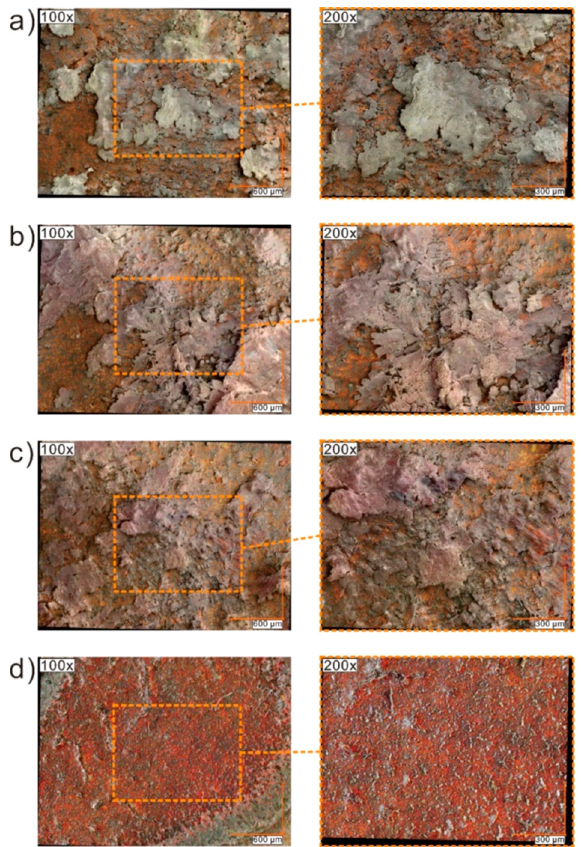
Figure 9. Real colored SEM images for Composite 1 ( a ), Composite 2 ( b ), Composite 3 ( c ), and Au nanoparticles ( d ) obtained by superimposing the SEM images on the optical images.